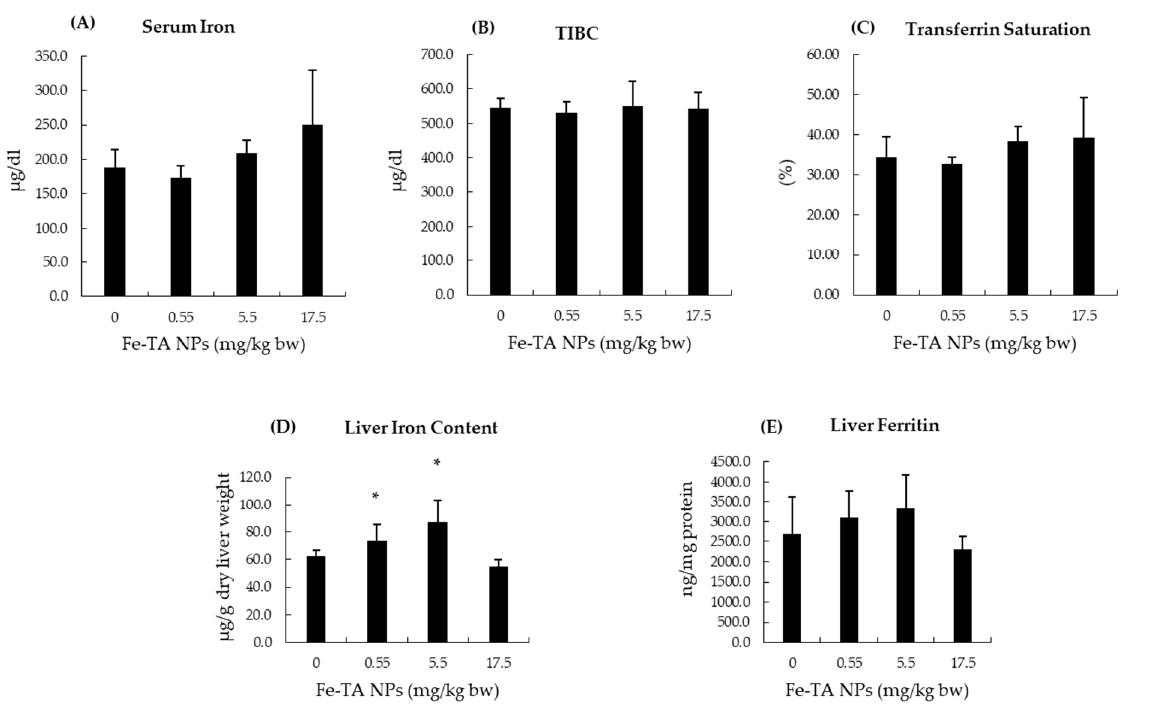
Figure 3. Effect of 10-week experiment of Fe-TA NPs on serum and liver iron parameters in rats. ( A ): Serum iron, ( B ): TIBC (Total iron binding capacity), ( C ): Transferrin saturation, ( D ): Liver iron content, and ( E ) Liver ferritin. Data are expressed as Mean ± SD. * p < 0.05, significantly different when compared with a control group.